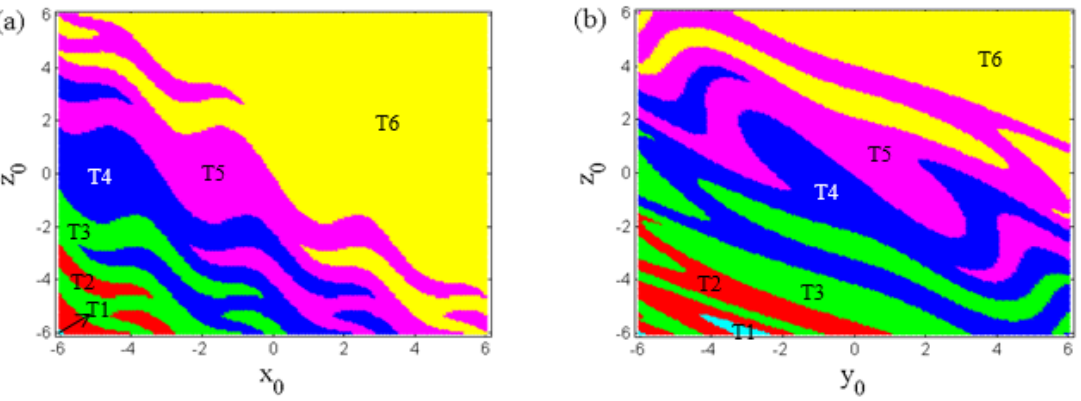
Figure 10. Attractor basin in the ( a ) x 0 - z 0 plane when y 0 = 0.02 and ( b ) y 0 - z 0 plane when x 0 = 0.02.